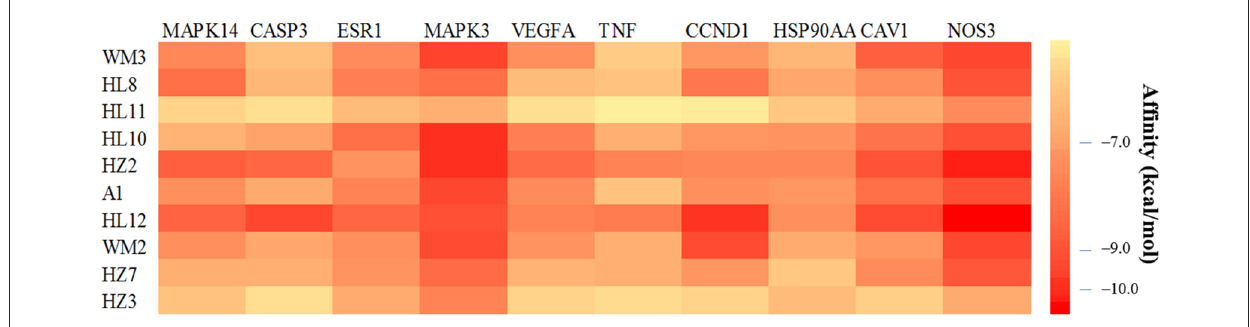
FIGURE7 Molecular docking heat map. A darker color indicates a stronger binding force between the ligand molecule and the receptor protein.